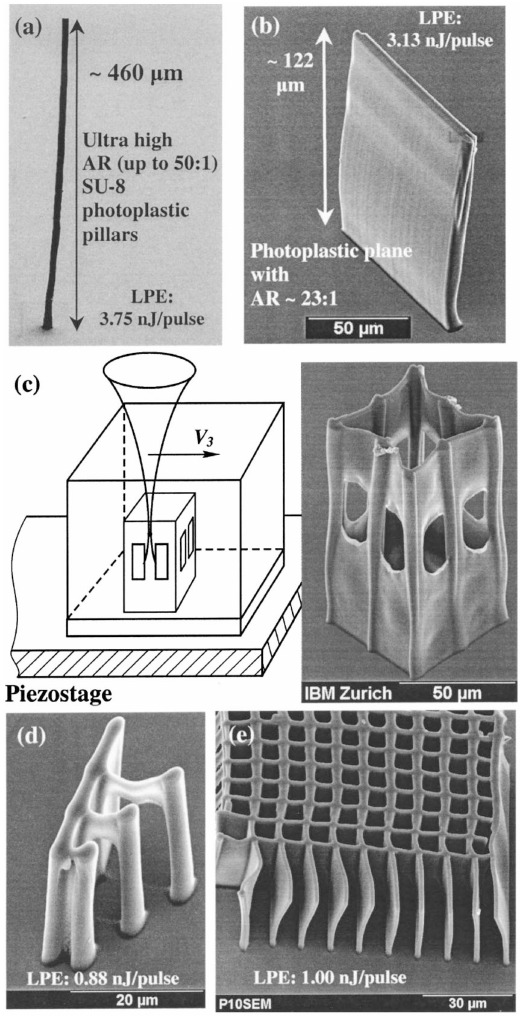
Figure 14. 3D high aspect ratio SU-8 microstructures using two photon absorption lithography technique. ( a ) SEM image of a 50:1 aspect ratio SU-8 pillar measuring; ( b ) SEM image of a SU-8 vertical plane (122 μ m high, aspect ratio of 23:1); ( c ) a 132 × 50 × 50 μ m 3 cage structure; ( d ) suspended SU-8 bridges of various lengths from 5 to 15 μ m long; and ( e ) a preliminary SU-8 photonic crystal structure with a periodicity of 10 μ m. Reprinted with permission from [44], copyright 2004, AIP Publishing